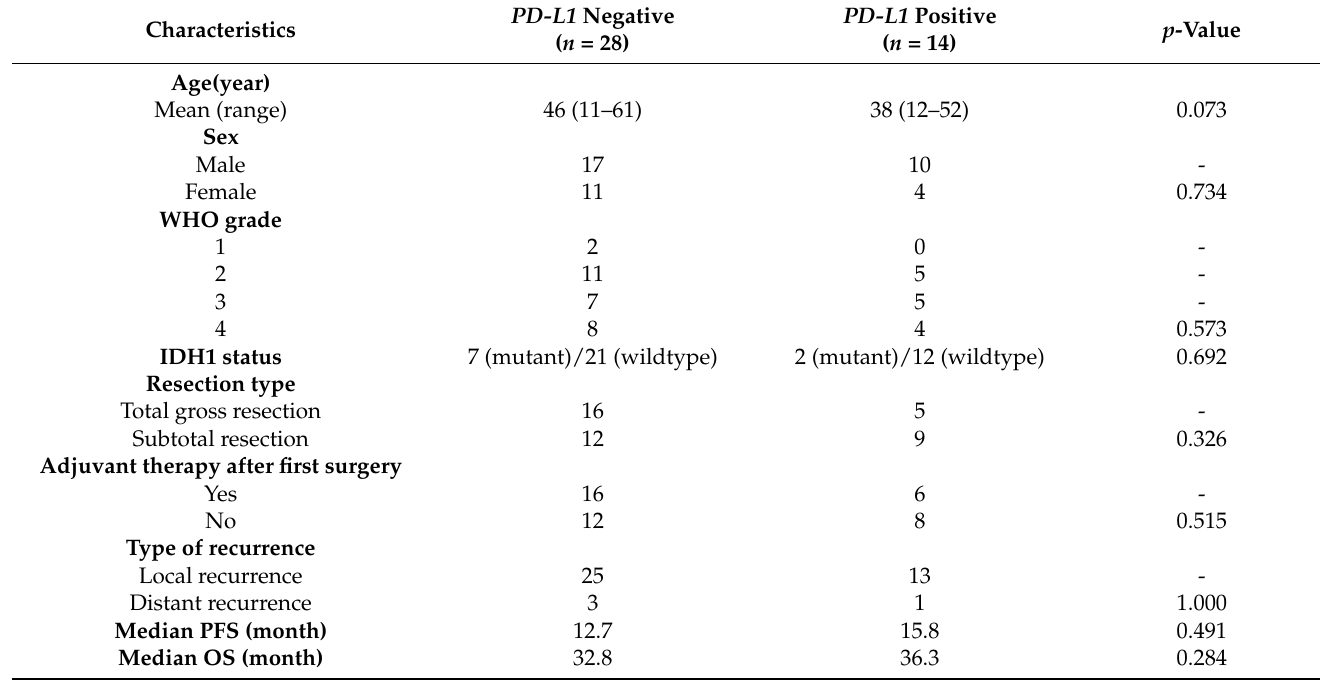
Table 4. Comparison of baseline clinical characteristics between PD-L1 -negative and PD-L1 -positive groups in primary